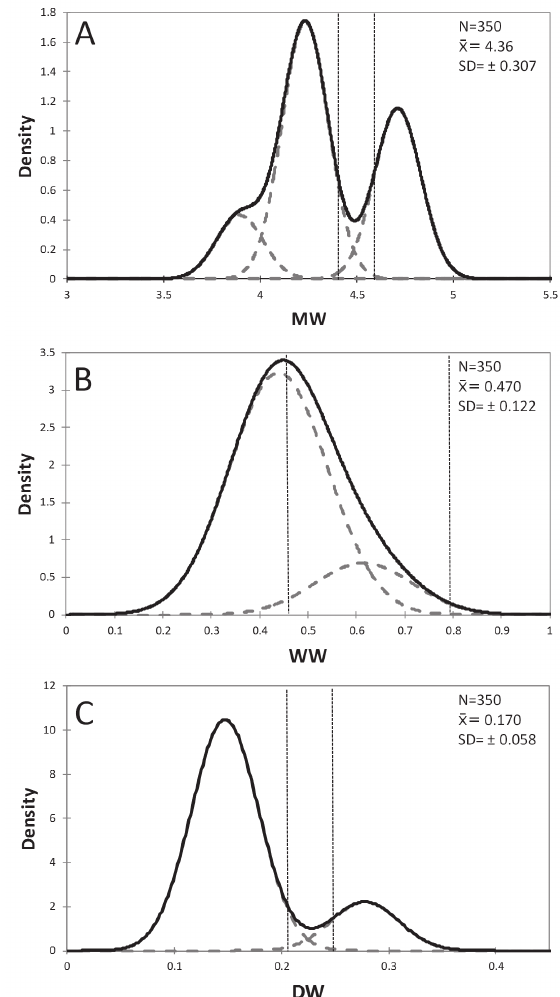
Figure 2. GMMs of hornet size, WW and DW. Vespa velutina size ( A ), wet weight ( B ), and dry weight ( C ) distribution using a Gaussian Mixture Model. Two-dimensional distribution is represented by continuous line A workers < 4.5 mm, gynes ≥4.5mm B workers < 0.618 g, gynes ≥ 0.618 g and C work- ers < 0.225 g, gynes ≥ 0.225 g. The dashed lines represent group densities. The 5% level of uncertainty is shown by dotted lines A 4.4 mm–4.58 mm B 0.445 g–0.797 g and C 0.202 g–0.247 g. 4 colonies: Colony 1, N= 30; Colony 2, N= 30; Colony 10, N= 240; Colony 11,